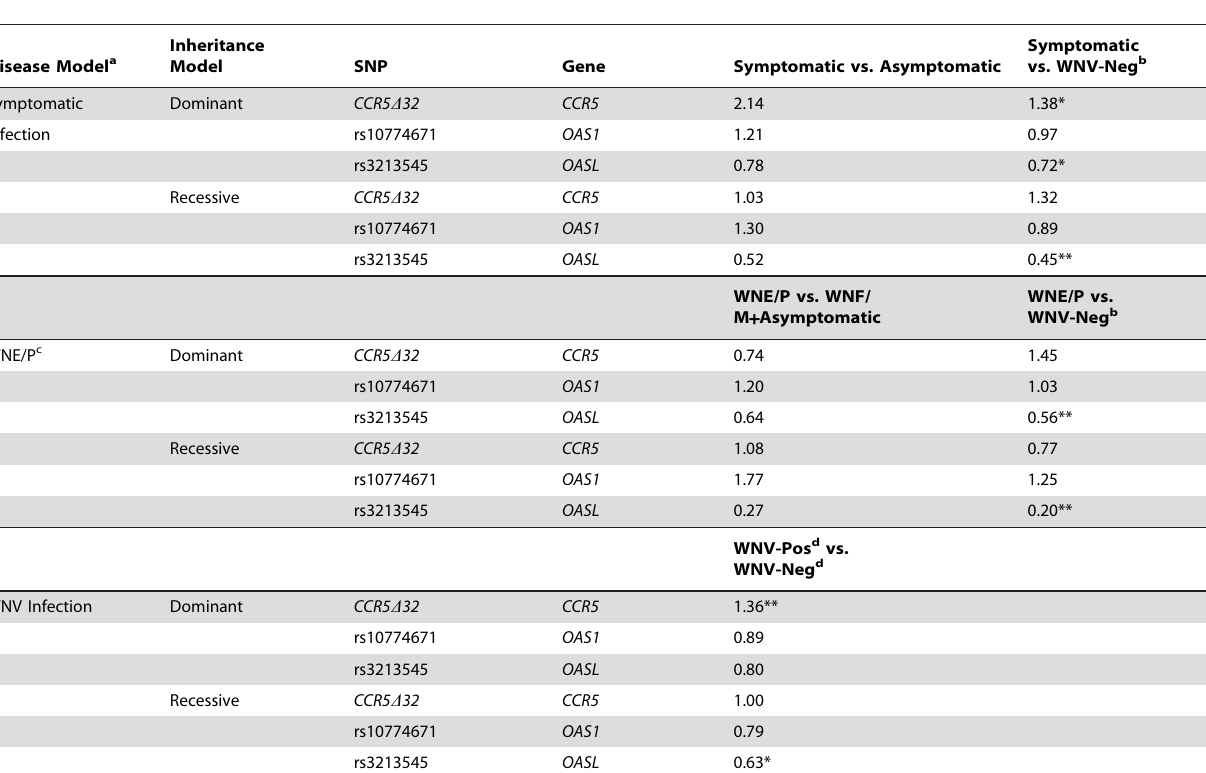
Table 4. Contingency table analysis odds ratios of SNPs previously associated with WNV infection, symptomatic infection, or disease